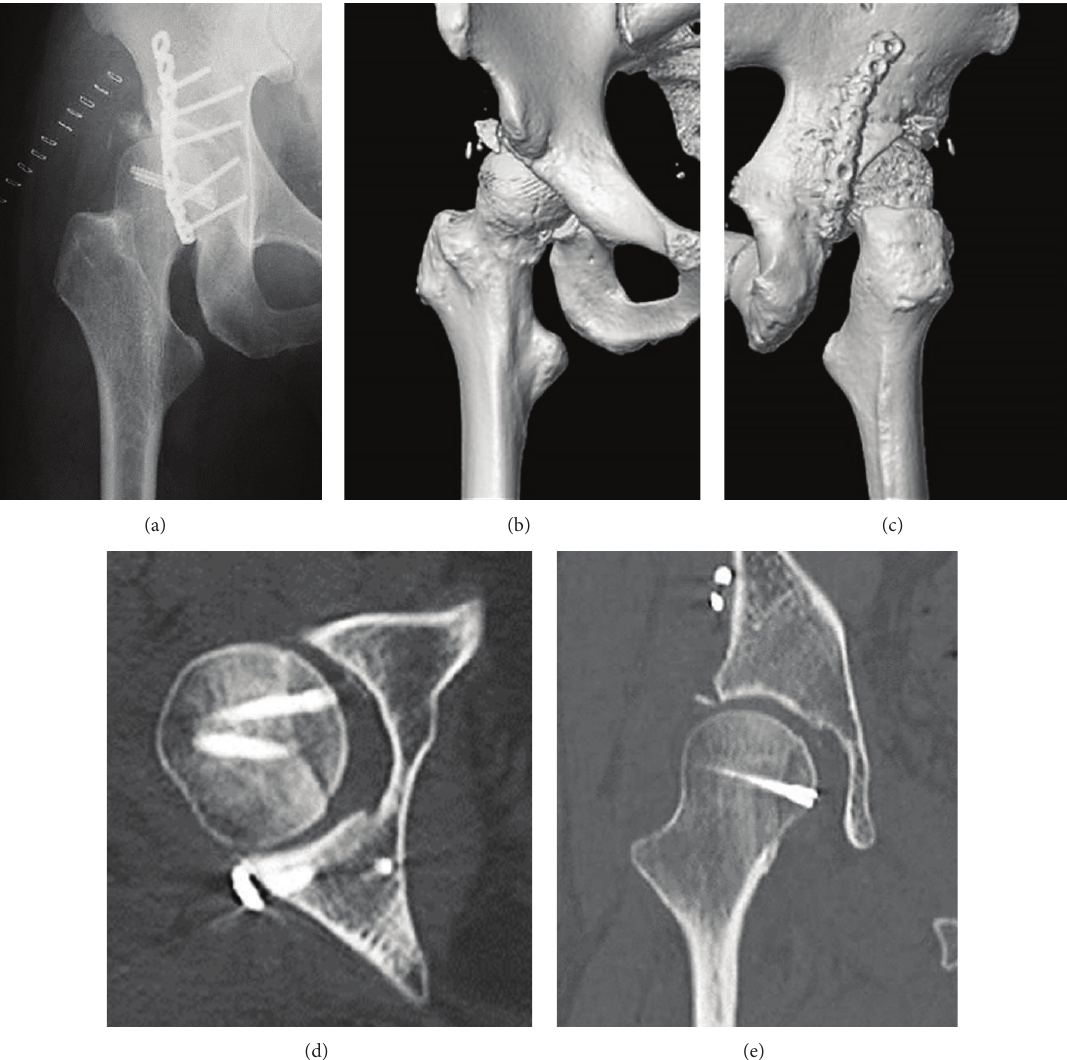
Figure 2: Case 1. (a) Anteroposterior X-ray image of the right hip after open reduction and internal fixation. (b) Anteroposterior three- dimensional computed tomography showing acceptable reduction of the femoral head. (c) Posteroanterior three-dimensional computed tomography showing acceptable reduction of the posterosuperior wall. (d) Axial computed tomography showing acceptable internal fixation of the femoral head and posterior wall. (e) Coronal computed tomography showing acceptable internal fixation of the femoral head and